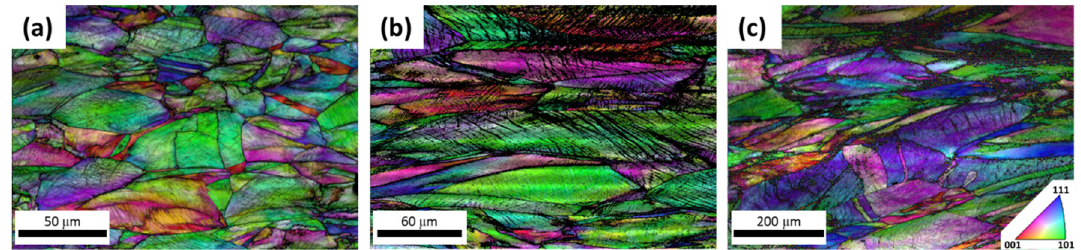
Figure 7. EBSD-OIM maps of the tensile tested alloy solution treated for two hours at ( a ) 1223 K (950